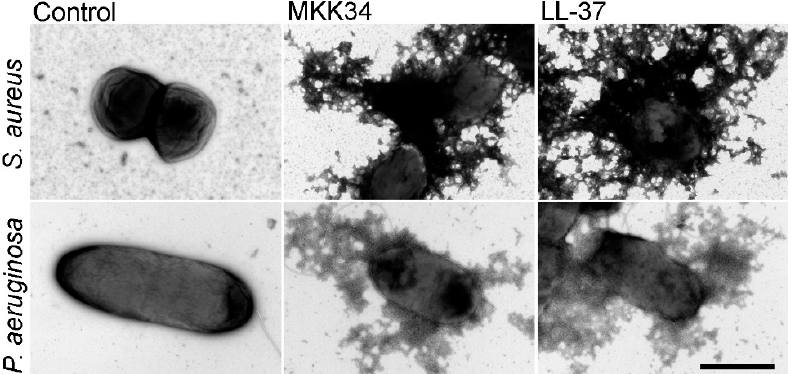
Figure 8. Electron microscopy analysis. Staphylococcus aureus and Pseudomonas aeruginosa were incubated with 30 μ M of MKK34 and LL-37 for 2 h at 37 °C and visualized by negative staining. Scale bar 1 μ m. Control: buffer control. From [7], image courtesy of Matthias Mörgelin, Lund University, Lund, Sweden.